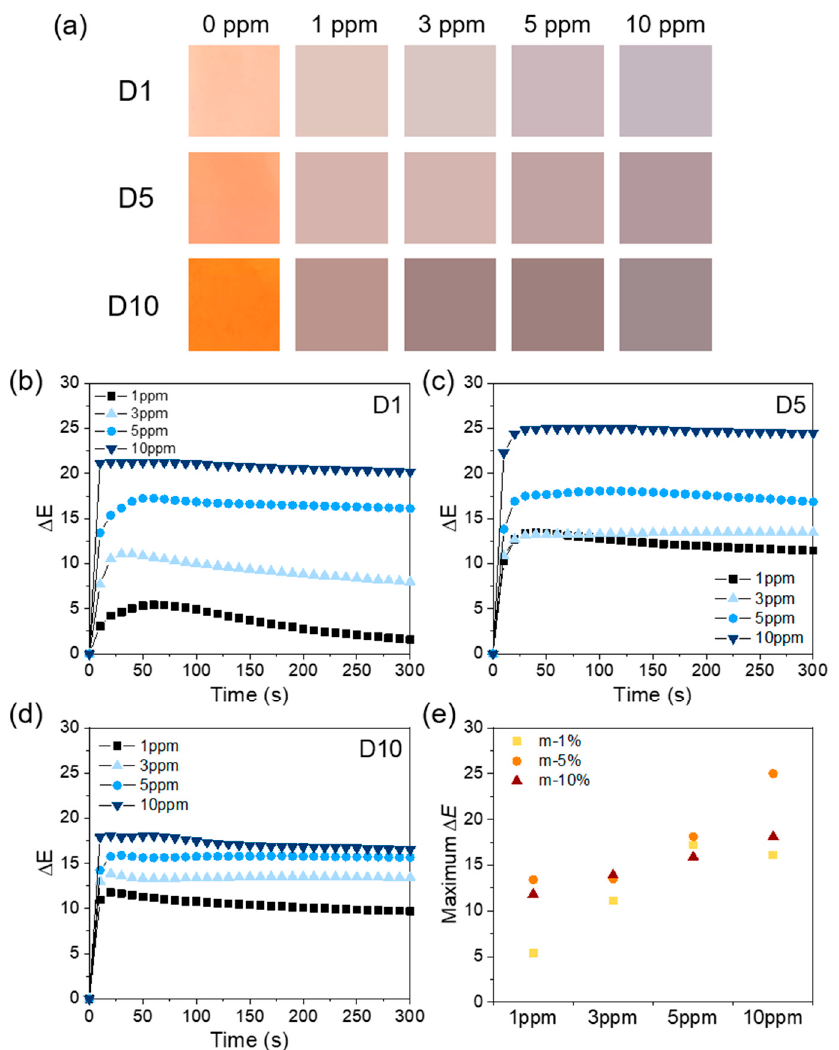
Figure 7. ( a ) Color changes of each nanofiber sensor after exposure to various NH 3 concentrations (1, 3, 5, and 10 ppm); ( b – d ) the time-dependent ∆ E values of the meta-aramid / dye 3 nanofiber sensor specimens after exposure to various NH 3 concentrations (1, 3, 5, and 10 ppm); and ( e ) the maximum ∆ E values of the meta-aramid / dye 3 nanofiber specimens containing various amounts of dye 3. Table 2. List of nanofiber-based colorimetric sensor for the NH 3 detection. Response Detection Functionality Washable Time Limit